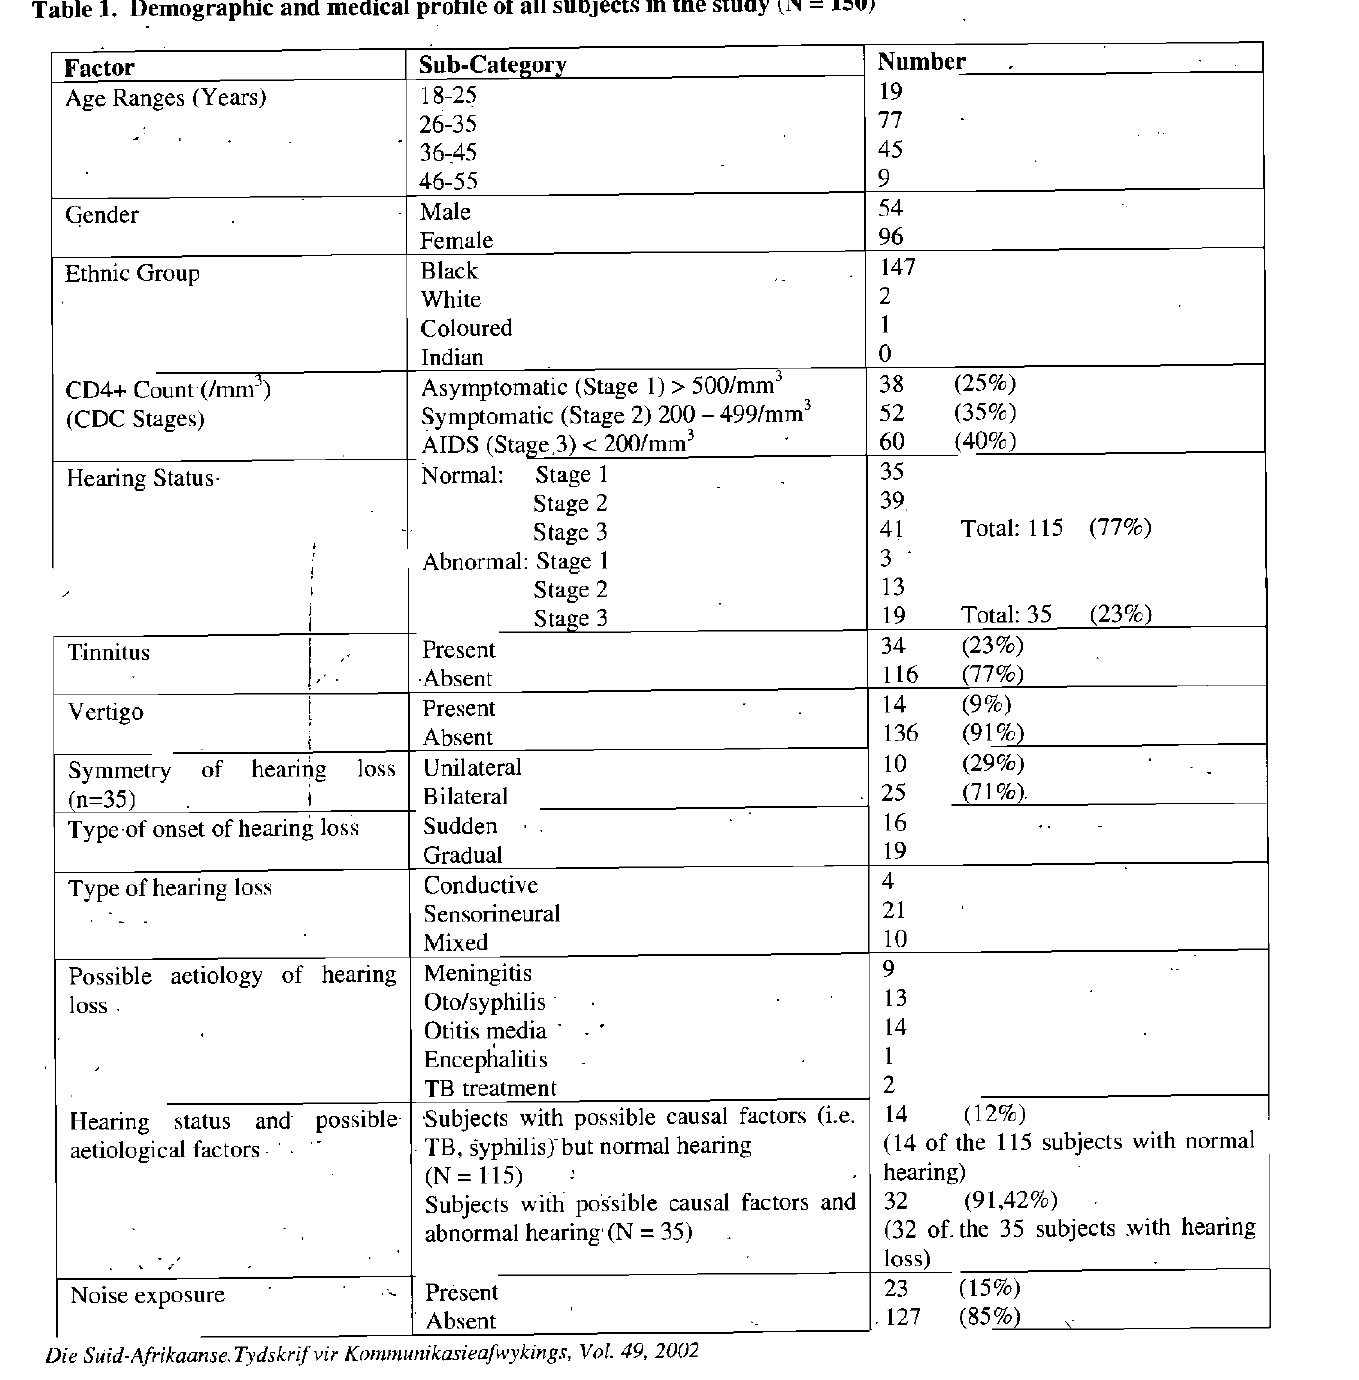
Table 1. Demographic and medical profile of all subjects in the study (N = 150) Factor Age Ranges